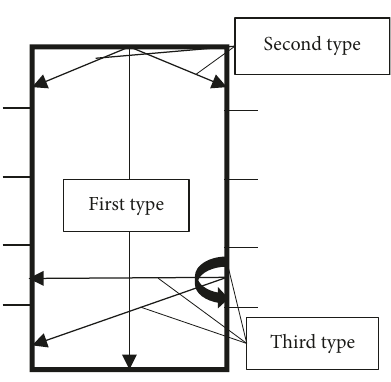
Figure 2: Radiation view factor diagram.